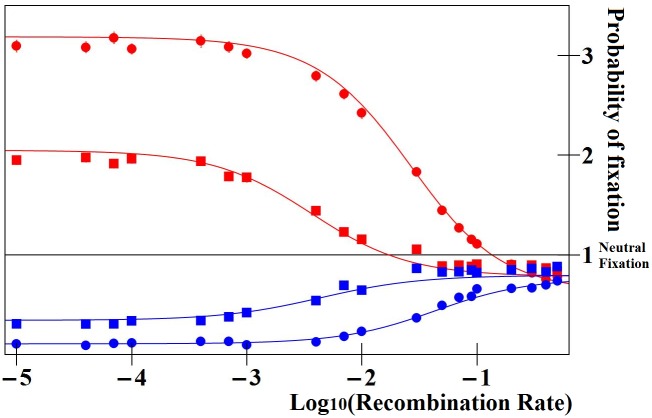
Ratio of fixation probabilities of mutations altering enhancer strength relative to that of a neutral mutation.In red, the mutant enhancer is three times stronger than the wild type; and in blue, three times weaker. Simulated and analytically predicted values (see methods) are represented by dots and lines, respectively. Values are reported for the case where enhancer strength evolution does not alter overall protein expression (model 1, see text), for various recombination rates between the enhancer and the gene (x-axis), for weak (s = 0.01, squares) or strong selection (s = 0.1, circles) and partial recessivity (h = 0.25). Results are illustrated for N
pop
u = 1 (where N
pop is the population size and u the gene mutation rate). Results for higher N
pop
u just need to be multiplied by a factor equal to N
pop
u. For instance the relative fixation probability for N
pop
u = 10 of tightly linked stronger enhancers would be ~20 or ~30, for s = 0.01 or s = 0.1, respectively. Weaker enhancers (blue) are always selected against, while stronger enhancers (red) are selectively favored provided that they are closely linked to the gene, and disfavored otherwise.